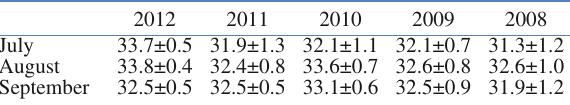
Table 1. – Monthly average sea surface temperatures (±standard deviation) in different years